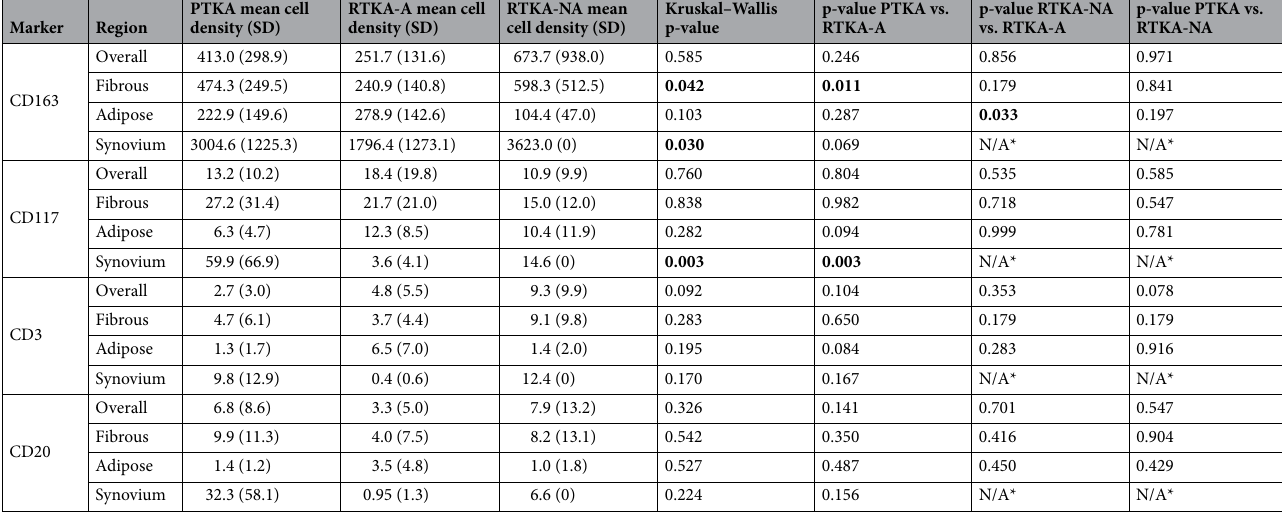
Table 3. Mean cell densities for CD163 + macrophages, CD117 + mast cells, CD3 + T-cells and CD20 + B-cells in the whole tissue and in the fibrous, adipose and synovial tissue regions. Significant values are in bold. PTKA = primary TKA, RTKA-A = revision TKA for arthrofibrosis, RTKA-NA = revision TKA for non- arthrofibrotic reasons SD = standard deviation. *There was only one RTKA-NA sample with synovial tissue; unable to perform statistical analysis with only one